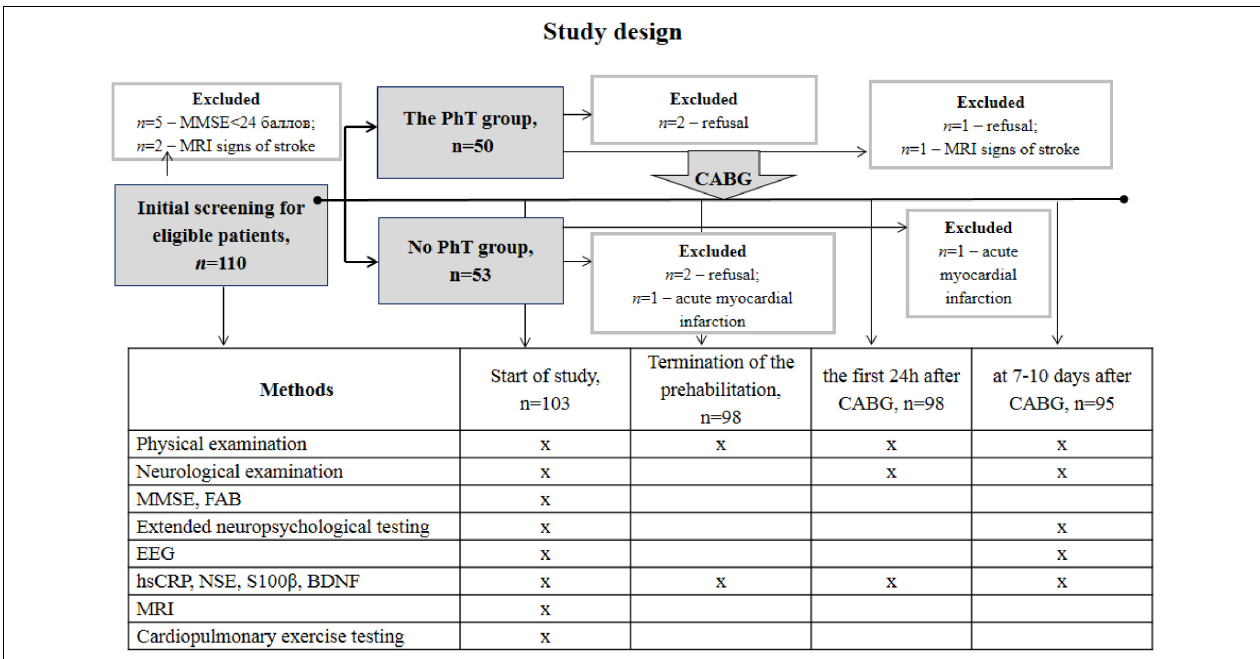
FIGURE 1 | Overview of the study design. PhT, physical training; CON, control.